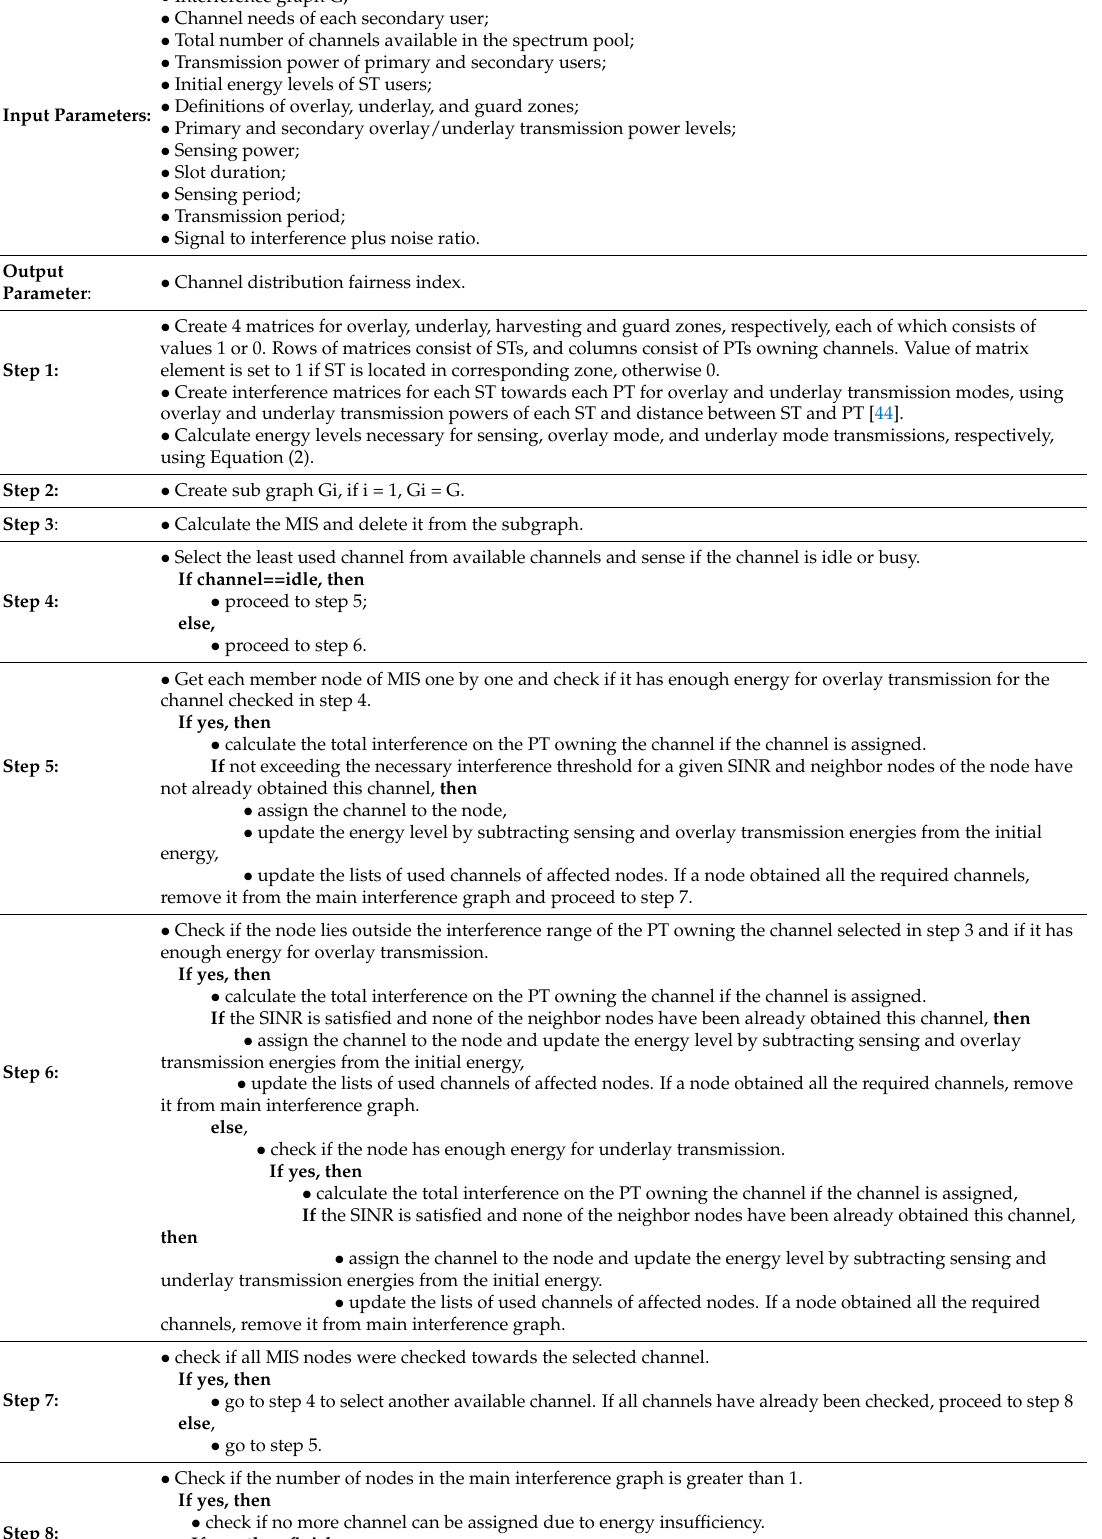
Table 2. Proposed algorithm using maximum independent sets (MIS) of interference